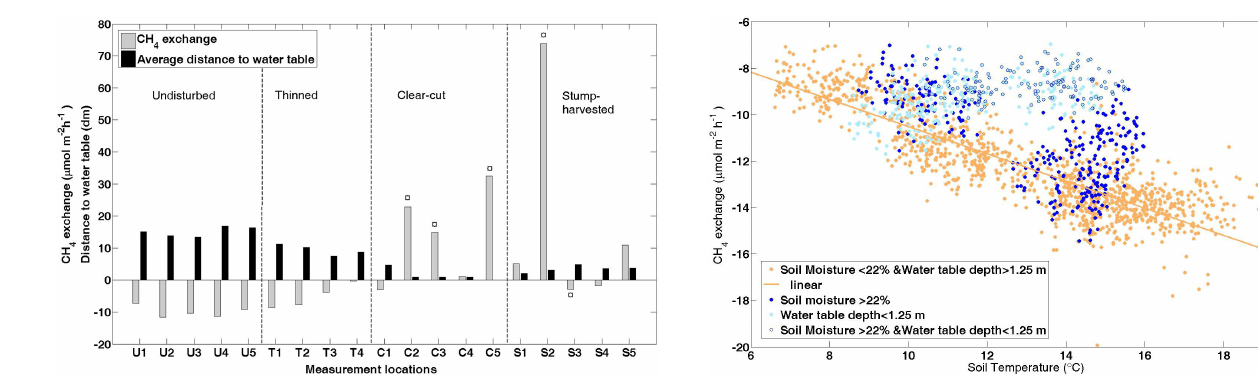
Figure 4. CH 4 exchange (µmolm − 2 h − 1 ) at all individual measure- ment locations with associated level of groundwater table. The wa- ter table depth at plot C 5 is close to zero and that is why the bar is not visible in the diagram. (cid:3) Measurement locations at which soil surface was disturbed during site preparation.